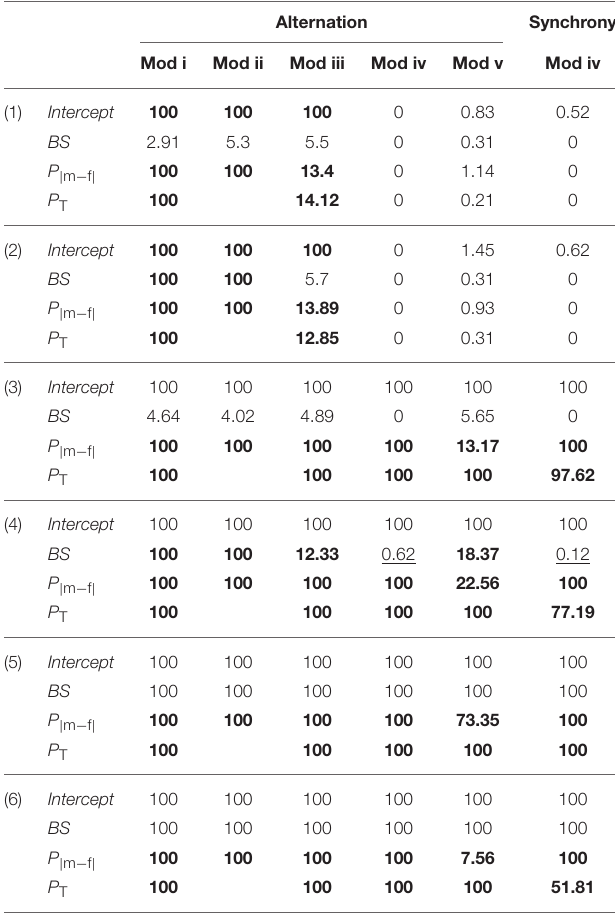
TABLE 3 | Percentage of significant results out of 1,000 simulations, for all factors of each of the 5 candidate models (models i to v) for analyzing alternation and model iv for analyzing synchrony, provided for each of the six simulated scenarios (numbers in brackets, see Table 1